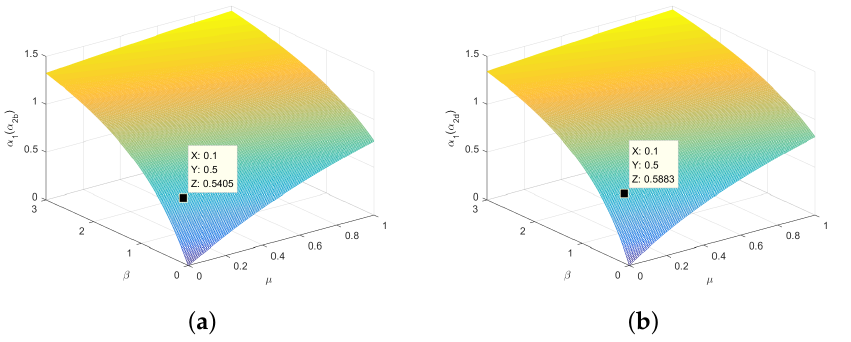
Figure 5. The relationship of ( µ , β , α 1 ( α 2 )) : ( a ) ( µ , β , α 1 ( α 2 b )) space; ( b ) ( µ , β , α 1 ( α 2 d ))